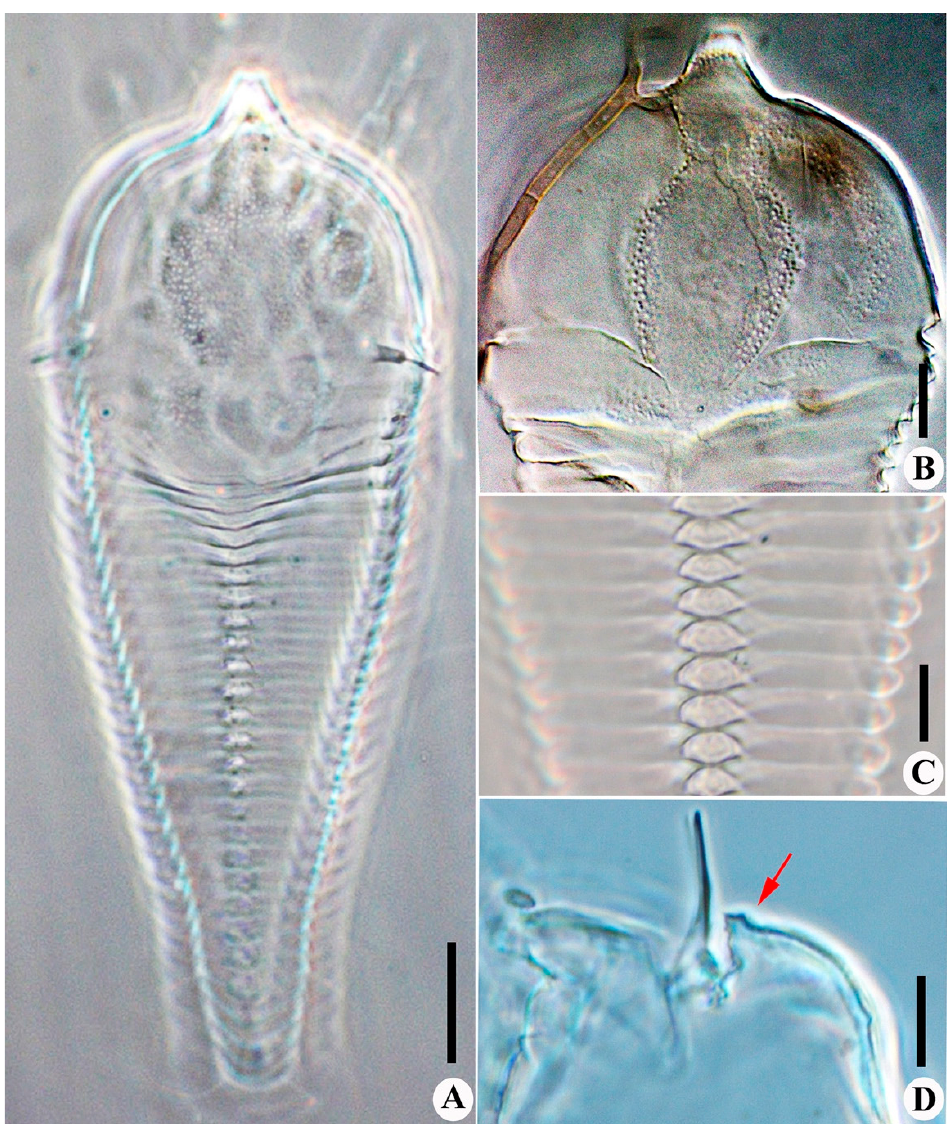
Figure 4. Scolotosus ehretus sp. nov. ( A ) dorsal view; ( B ) prodorsal shield; ( C ) doral annuli; ( D ) lateral view of the gnathosoma; the arrow indicates the lateral view of the frontal lobe. Scale bar: 20 μ m for A; 10 μ m for B, C, D.